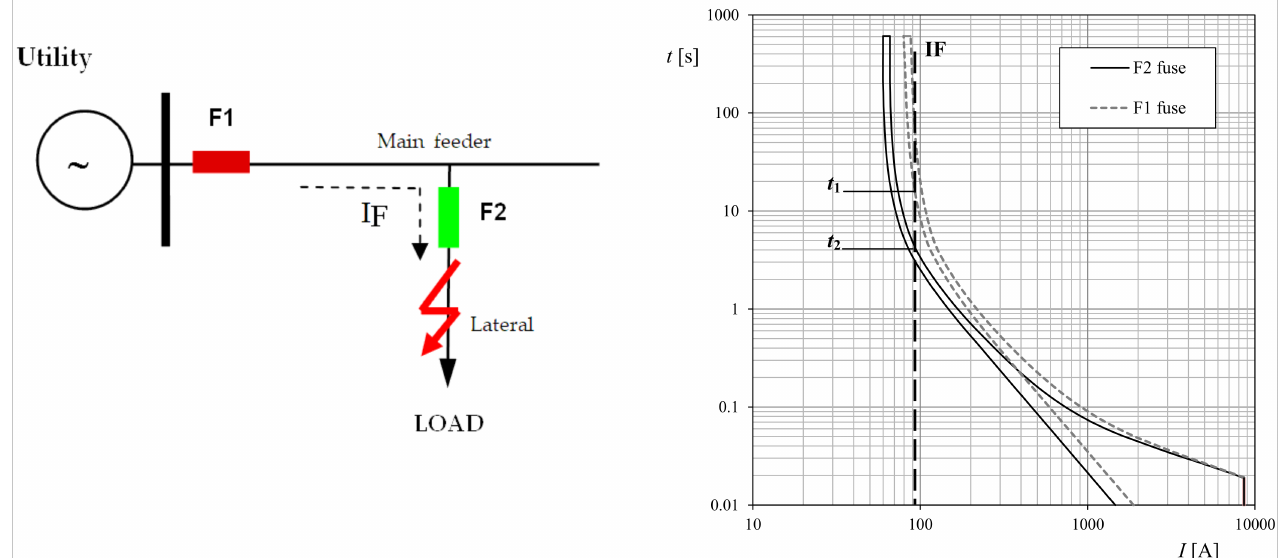
Figure 2. Classic coordination between protective fuses in non-DG radial distribution networks. ( Left ) Sketch of a radial distribution network without the presence of a DG. ( Right ) Operating characteristics curves of protection fuses F1 and